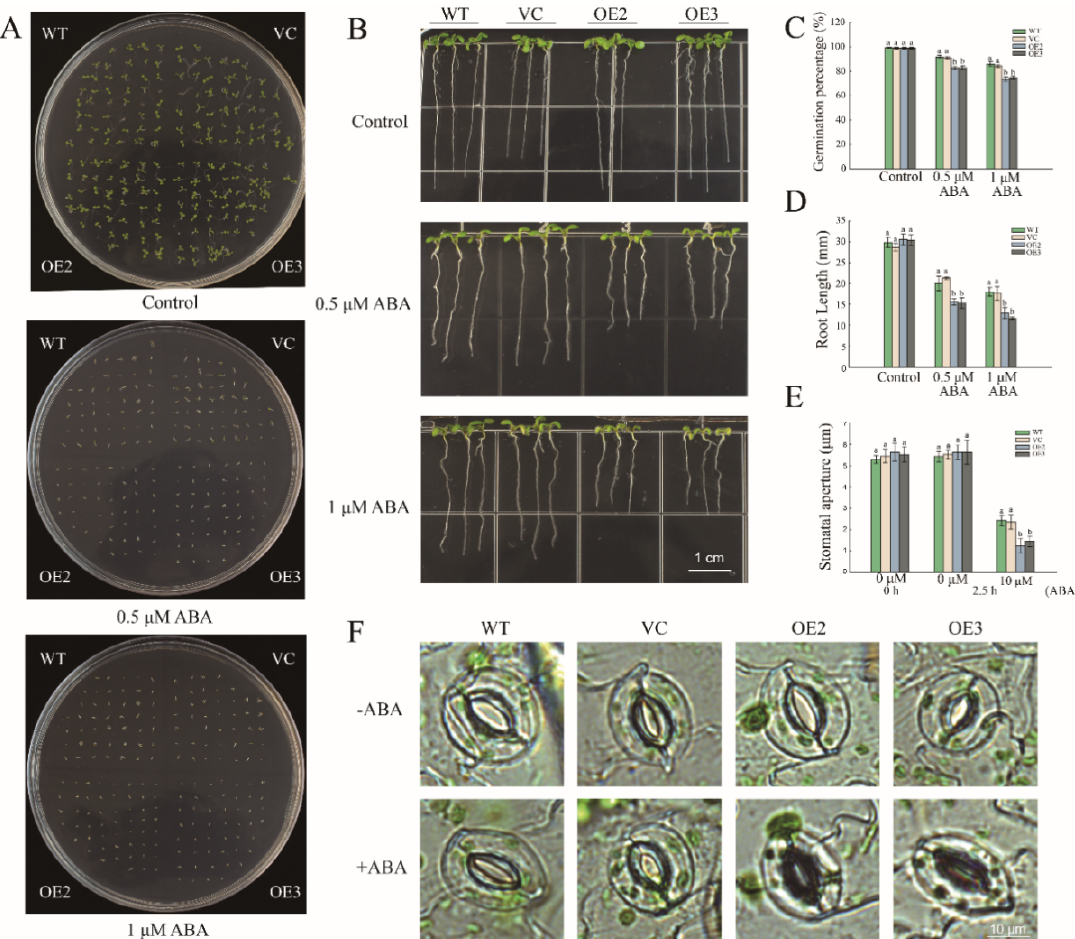
Figure 6. The stomatal aperture of PwNAC11 overexpression lines was positively modulated by ABA. ( A ) Germination assays for different lines under different concentrations of ABA treatments. ( B ) Root length assays for different lines under different concentrations of ABA treatments. ( C ) Quantification of germination percentage under ABA treatments. ( D ) Quantification of root length under ABA treatments. ( E ) Quantitative comparisons of stomatal aperture calculated by ImageJ software. ( F ) The observation of stomatal aperture of OE, WT and VC lines photographed by biomicroscope (DM2500, Leica). Different letters indicate the significant differences at p < 0.05.